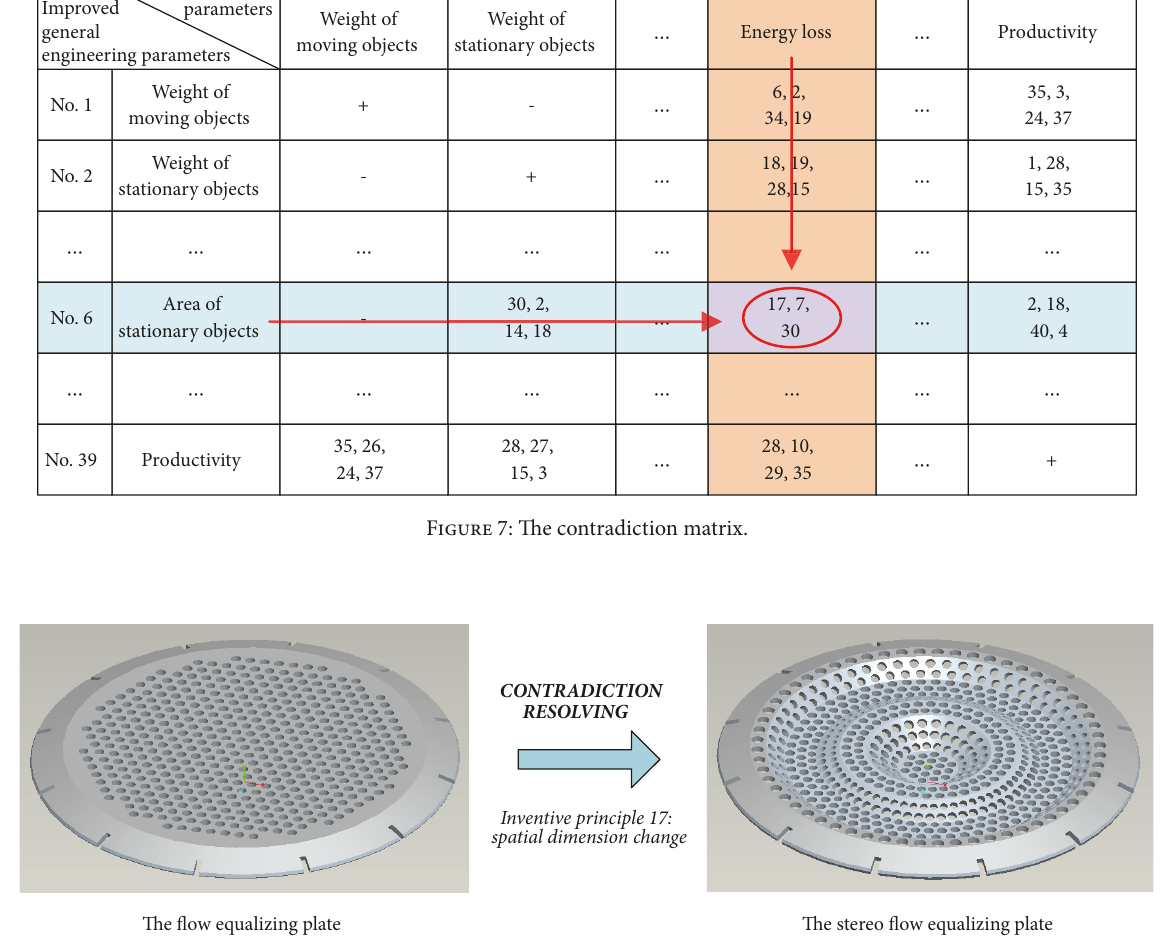
Figure 8: Curving the flow equalizing plate.